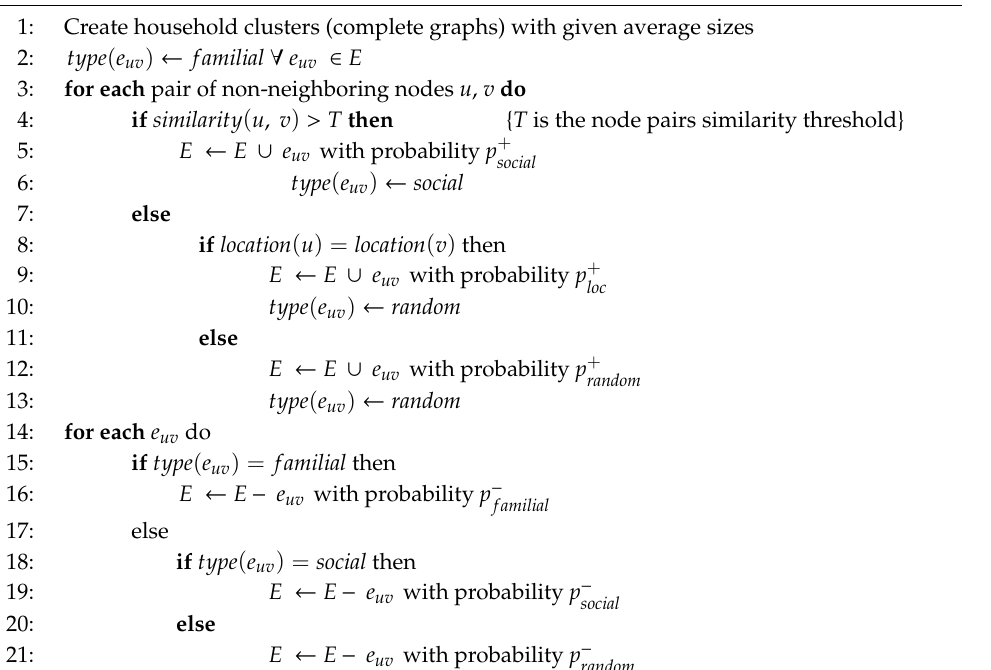
Algorithm 1 Contact network